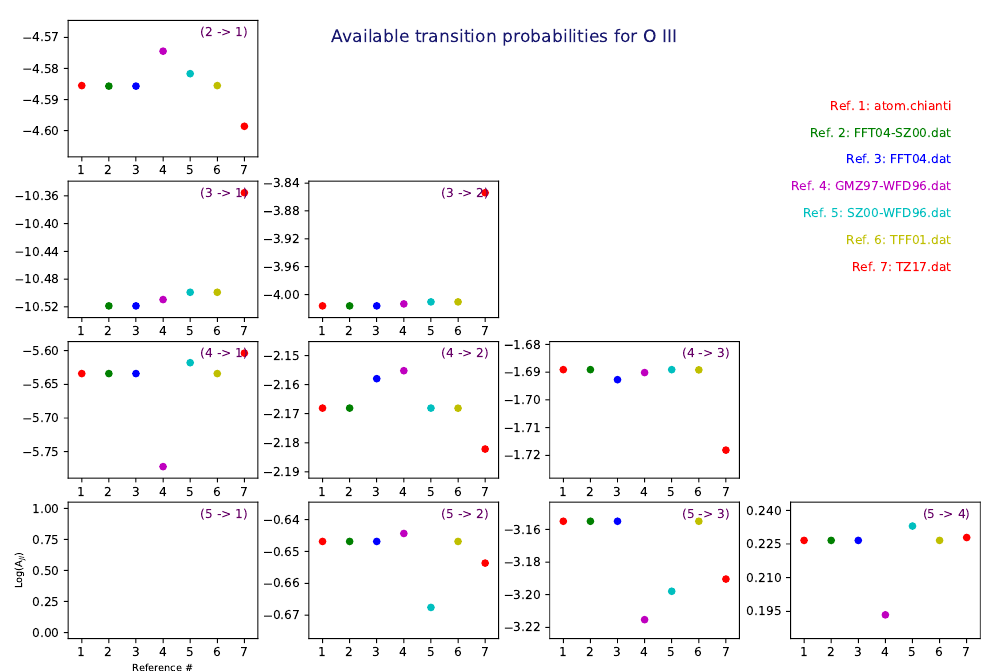
Figure 3. O III A -value diagram obtained with the plotAllA method of the DataPlot